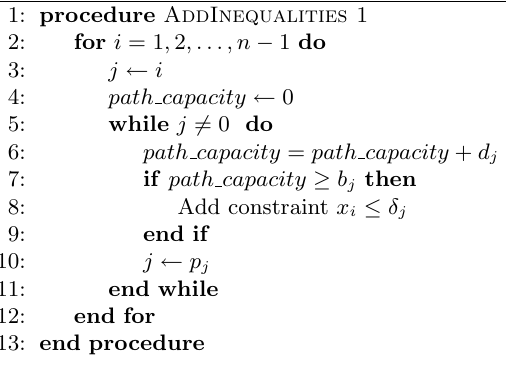
Algorithm 2 Add first set of valid inequalities to ETKP